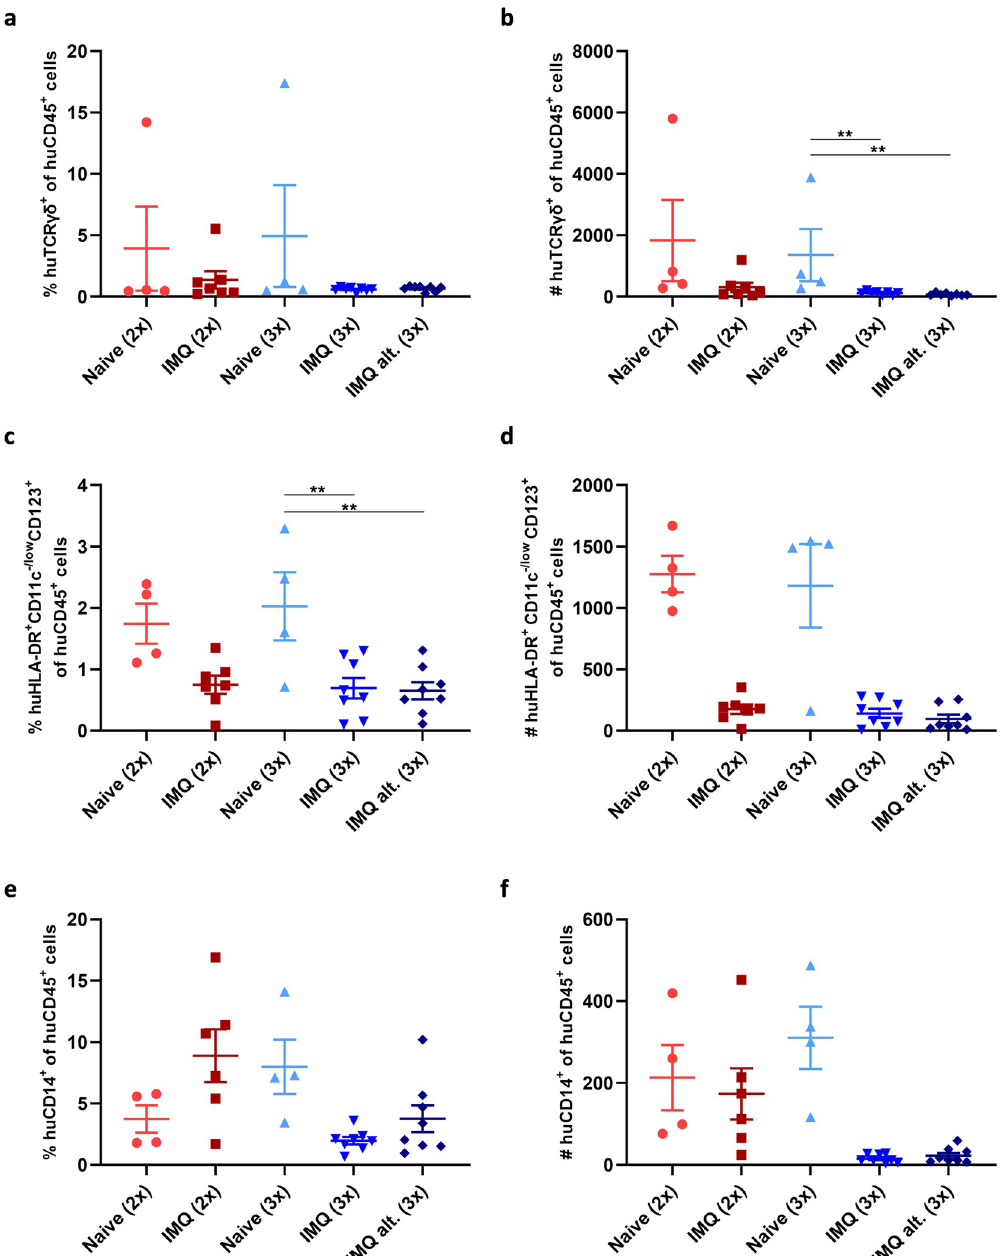
Fig 8. Human immune cells in blood and spleen. (a) Percent and (b) number of human γδ TCR + of human CD45 + cells and (c) percent and (d) number of human pDCs of human CD45 + cells were analyzed in spleen cell suspensions by flow cytometry at terminations. Percent and (e) number (f) of human monocytes of human CD45 + cells were analyzed by flow cytometry on blood at terminations.